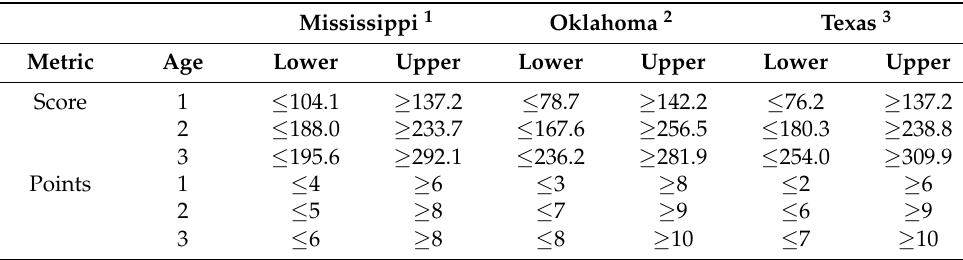
Table 1. Age-specific lower and upper antler point and score (cm) quartiles used in antler group comparisons of white-tailed deer ( Odocoileus virginianus ) from Mississippi (1999–2001), Oklahoma (1991–2005) and Texas